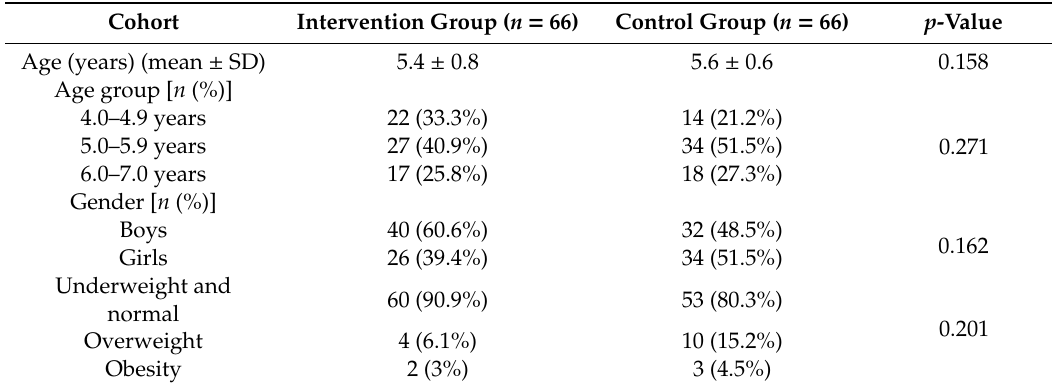
Table 2. Demographic